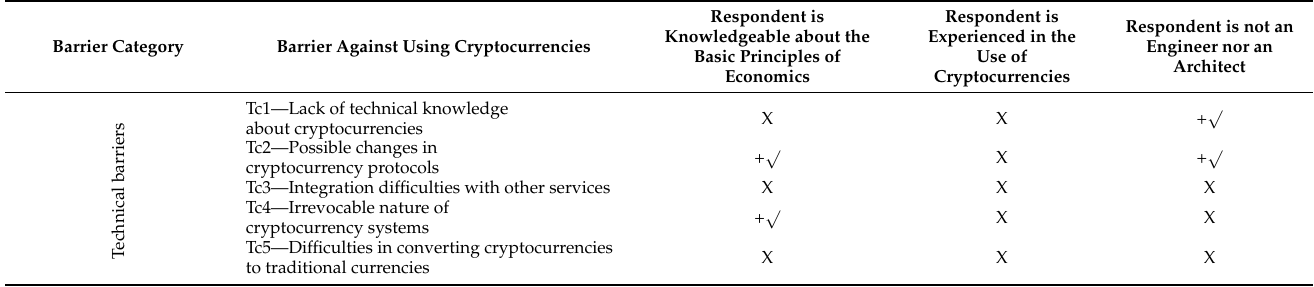
Summary of the differences in respondents’ opinions about the barriers against using